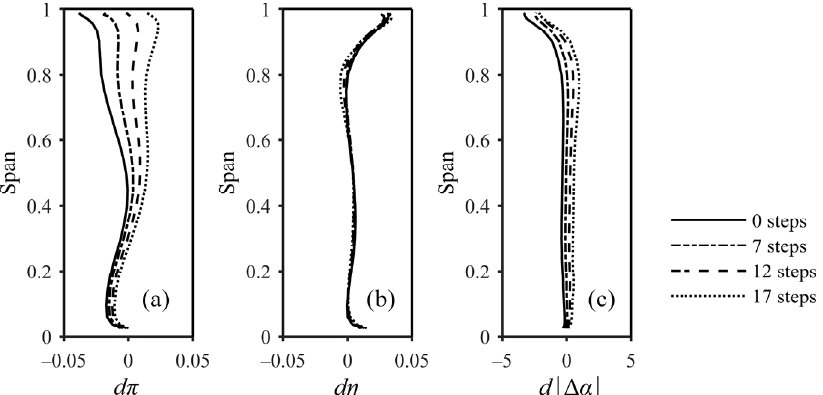
Figure 17. Deviation of the local performance distribution in different spans: ( a ) pressure ratio, ( b ) efficiency, and ( c ) absolute flow angle. ( b ) efficiency, and ( c ) absolute flow